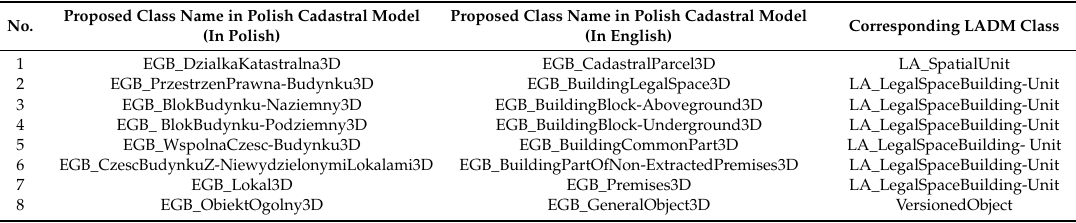
Table 1. Proposed new classes for the 3D cadastral model, with their names in Polish and English and the corresponding Land Administration Domain Model (LADM)